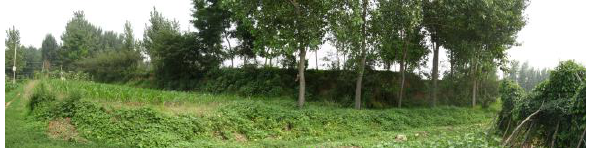
Figure 19. The current situation of Ni ruins 2.4 Lan’s Helplessness: Congenital Deficiency. Lan was the weakest state in Three Zhu, with poor territorial geographical environment and no title at all. In terms of macroscopic geographical landscape, Capital Changlv was located in the plains between two mountain ranges in east-west direction, with Xiaozhu on the east and Xue on the west; four sides suffocated and hinterland range was limited, which made it a congenital deficiency small country (Fig. 20).